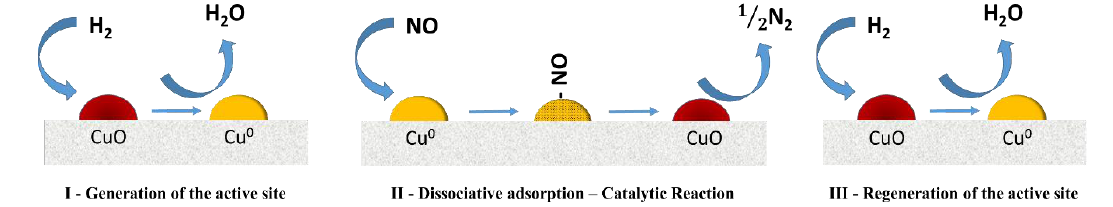
Table 4. NO conversion and NO to N 2 selectivity from the catalytic tests 1 .